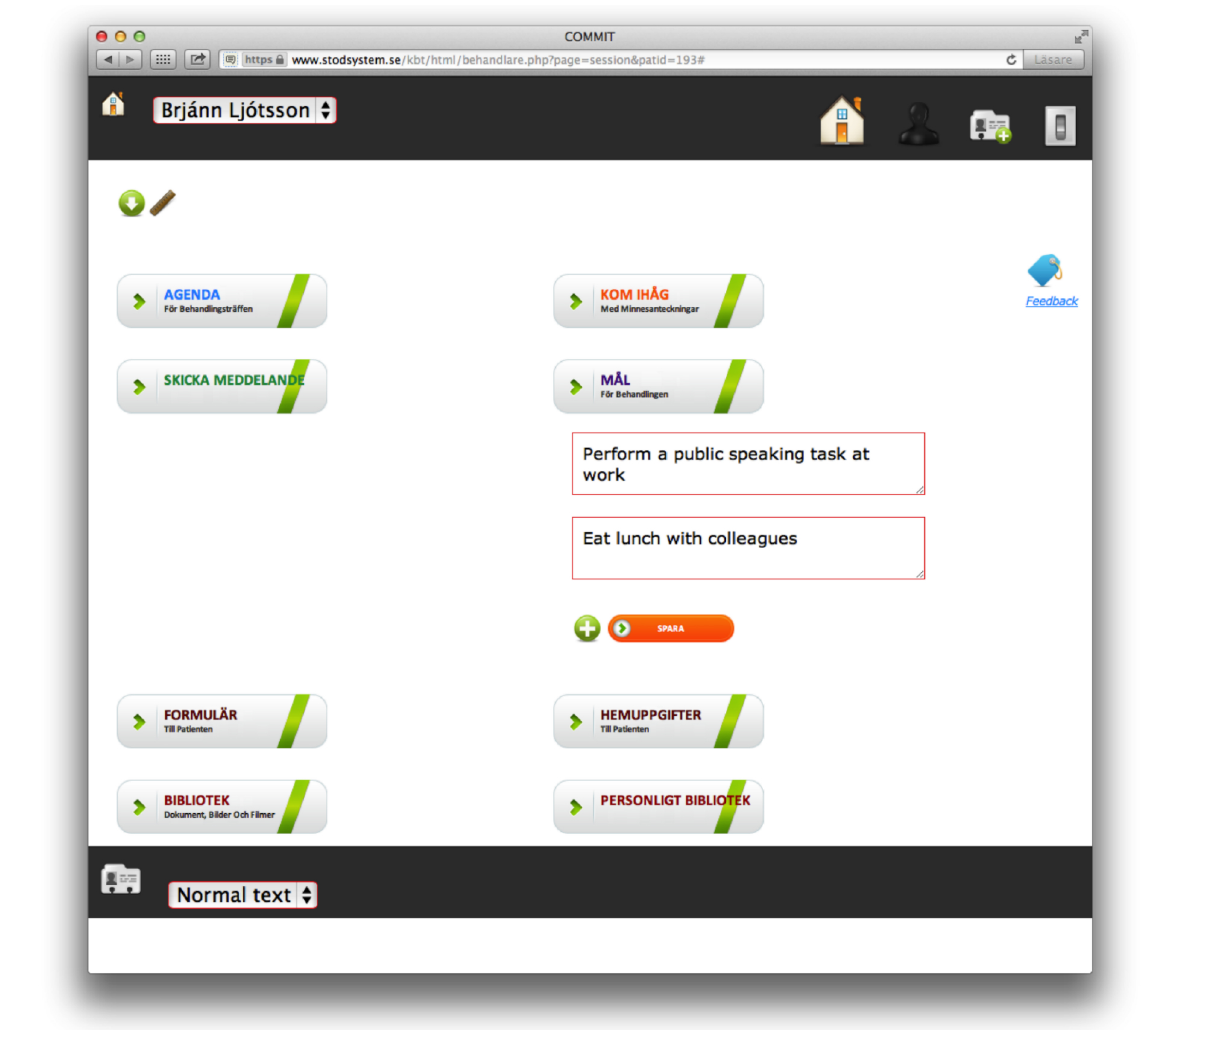
Figure 1. Screenshot of the Internet-based support